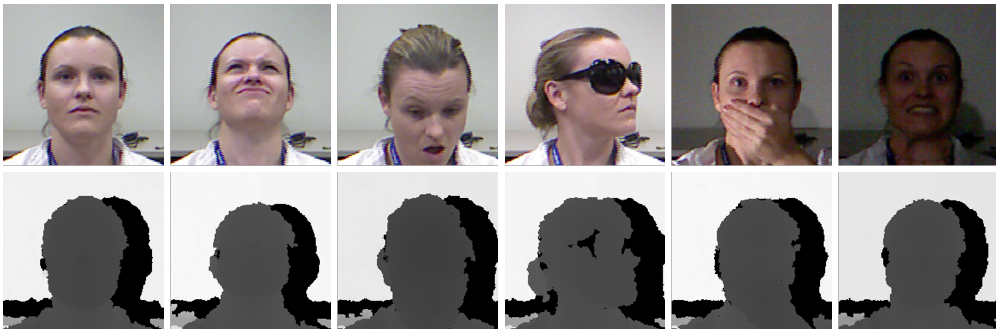
Figure 6. RGB and depth samples taken from the CurtinFaces dataset. As shown, different head poses, expressions, light variations, and garment occlusions are included.